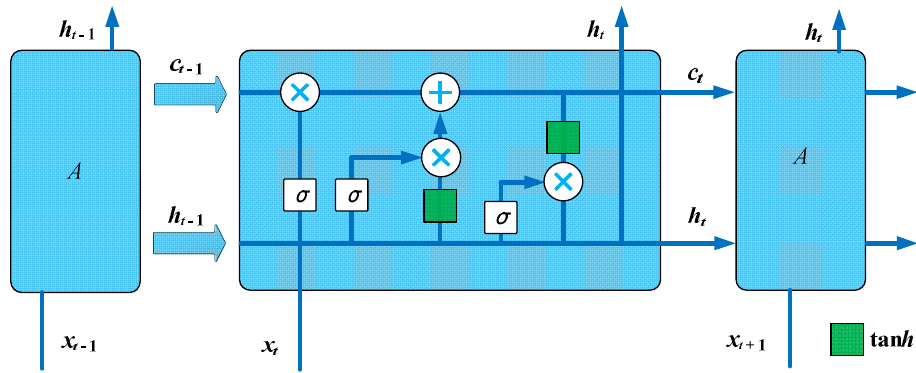
Figure 3. LSTM neural network